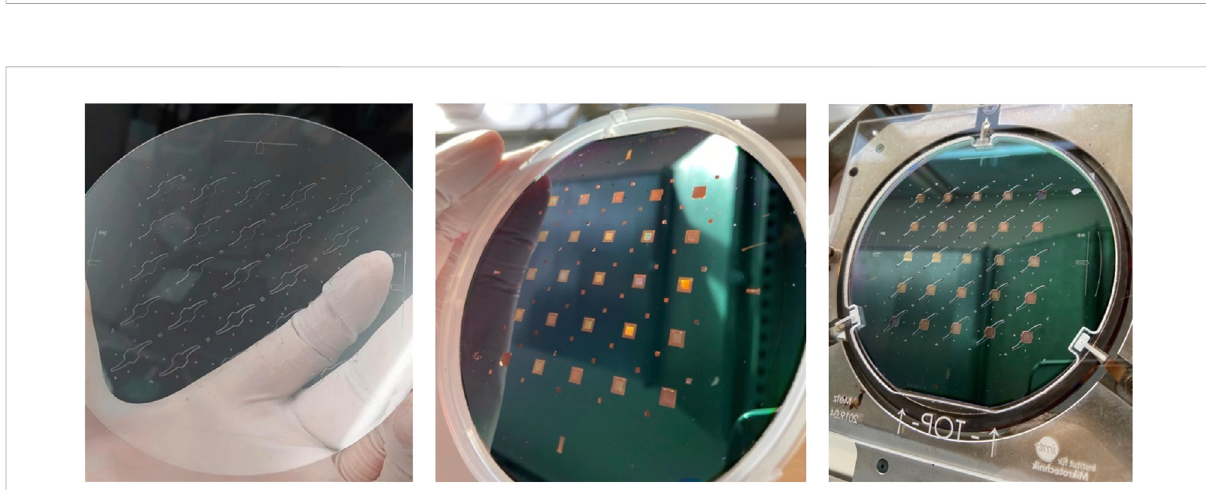
FIGURE 4 Left: structured 4-inch glass wafer representing the upper glass layer. Middle: structured silicon wafer with the Si x N y membrane. Right: structured silicon aligned with the 0.7 mm thick glass wafer comprising the wet etched upper compartments, placed in the tool for anodic bonding. With one wafer 5 × 5 chip systems can be produced. The picture shows a wafer carrying a preliminary chip design slightly deviating from the one discussed in this paper.